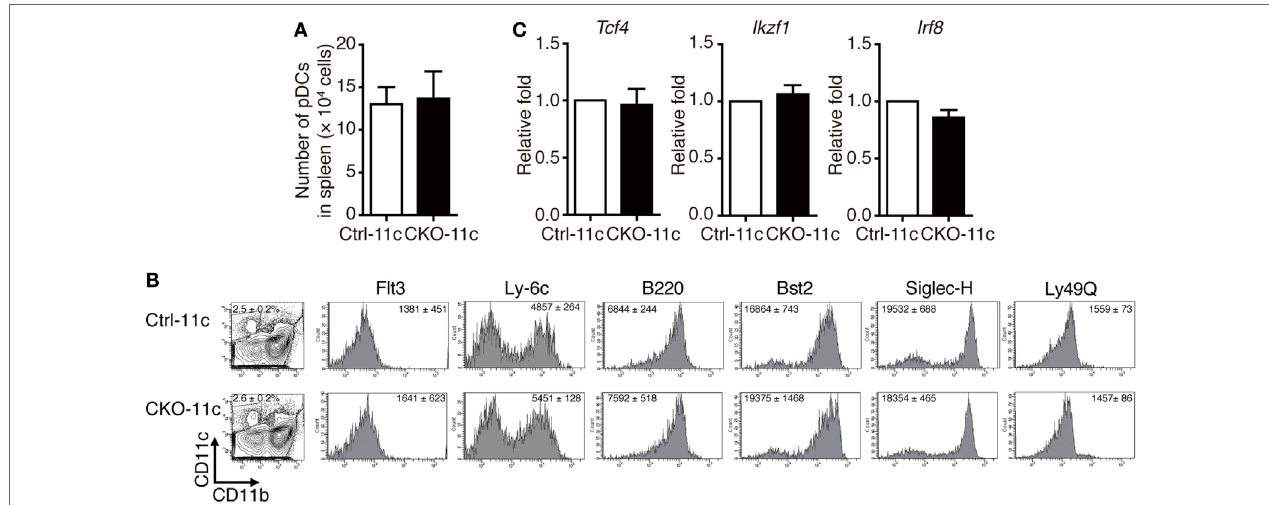
FigUre 2 | Comparable plasmacytoid dendritic cell (pDC) development in CKO-11c mice and Ctrl-11c mice. (a) pDC numbers in the spleen of Ctrl-11c and CKO-11c mice were enumerated. (B) Flow cytometric analysis showing the expression of various pDC maturation markers in CD11b − CD11c + bone marrow cells isolated from Ctrl-11c or CKO-11c mice. The frequency of the CD11b − CD11c + population and the mean fluorescence intensity of the staining in each histogram are indicated. (c) RT-quantitative PCR showing the mRNA expression levels of E2-2 ( Tcf4 ), Ikaros ( Ikzf1 ), and IRF8 in splenic pDCs isolated from Ctrl-11c or CKO-11c mice. Results represent the mean ± SEM and were analyzed by two-tailed unpaired Student’s t -test [ n = 3 in (a − c)